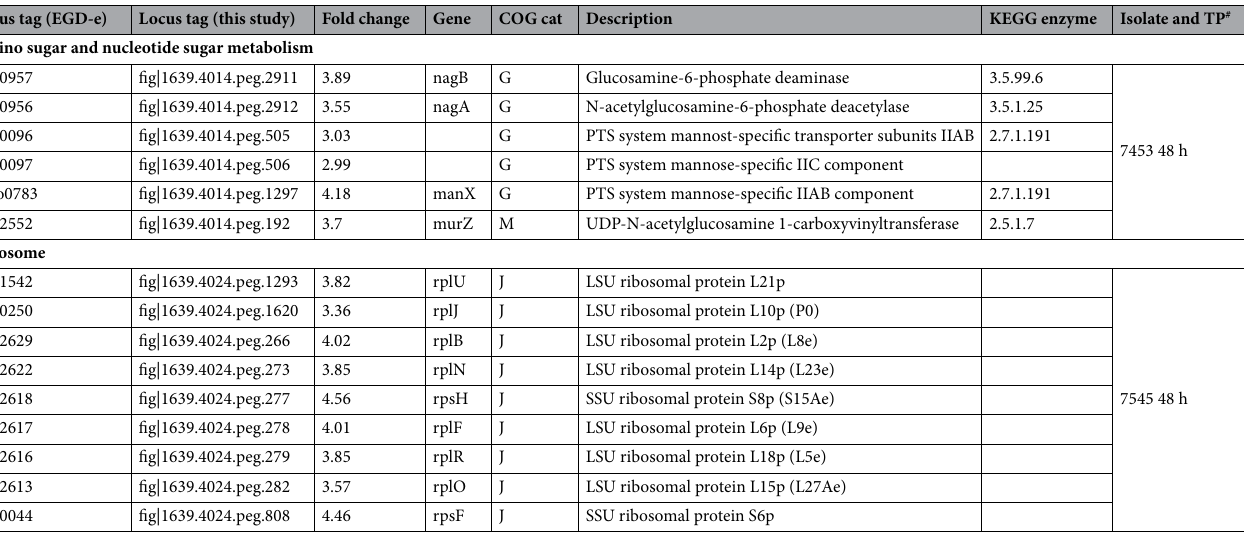
Table 2. Overexpressed pathways in differentially* expressed genes at 24 and 48 h in L. monocytogenes isolates 7453 F and 7545 F . *FDR < 0.01 log 2 fold change. # Time point.